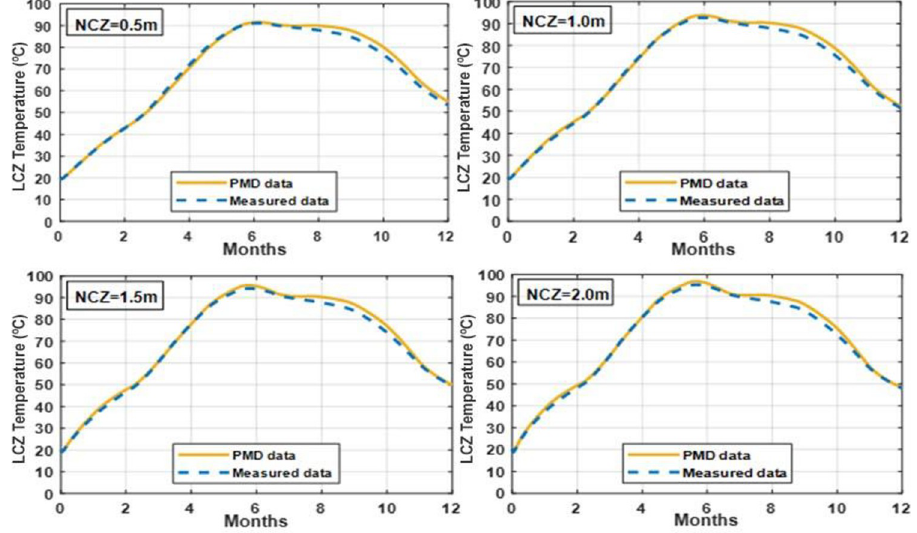
Fig 14. Effect of different thickness of NCZ on the temperature of LCZ with UCZ = 0.3 m and LCZ = 0.7 m for whole year simulation under PMD and measured climatic conditions of